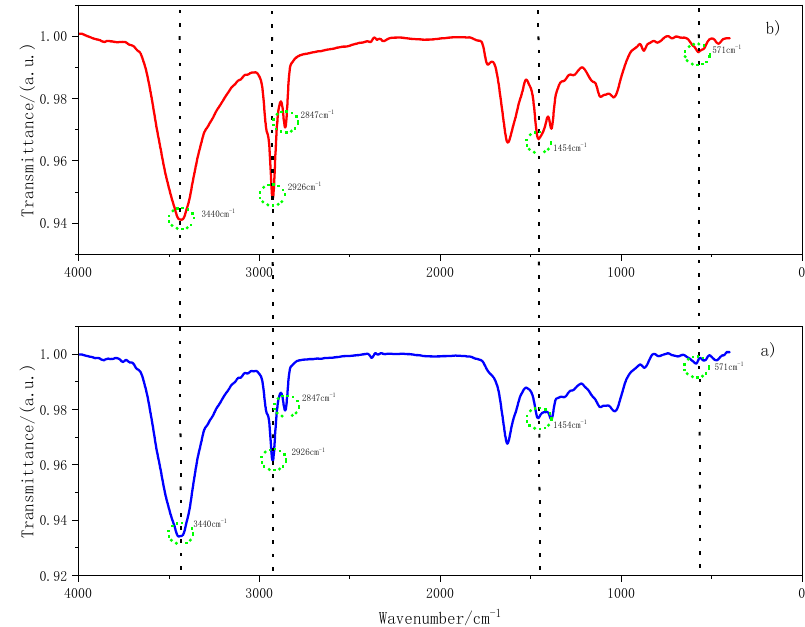
Figure 9. Infrared spectra of basalt fiber before and after modification: ( a ) BF pretreatment; ( b )